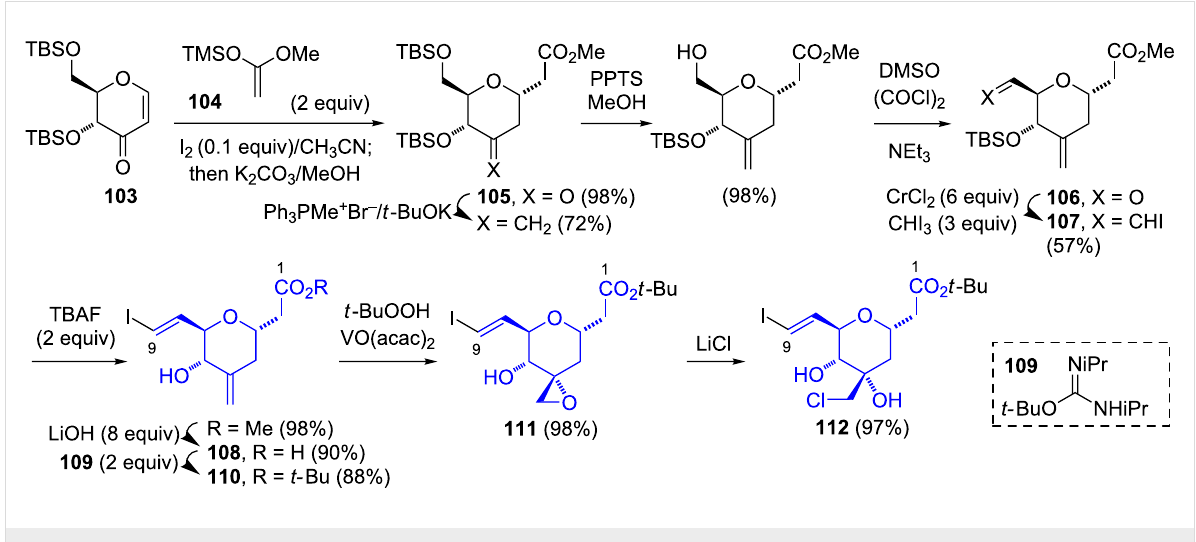
Scheme 17: Nicolaou synthesis of the C-1–C-9 segments of spliceostatin D ( 9 ) and thailanstatins A ( 7 ) and B ( 5